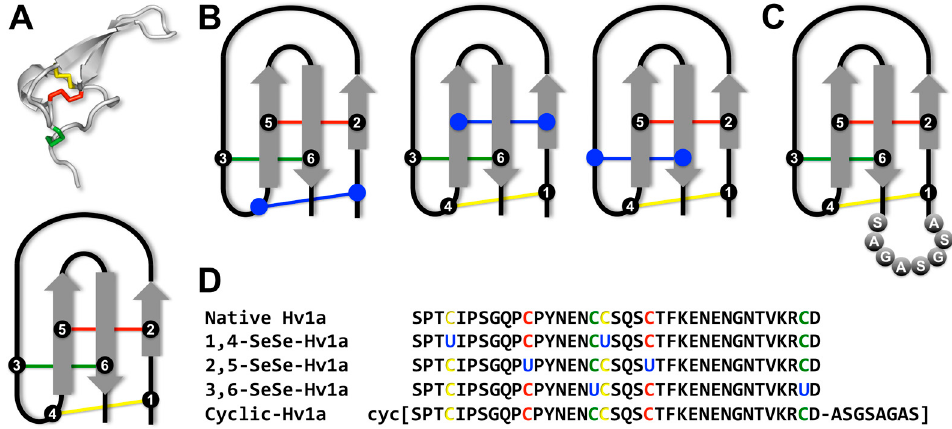
Figure 1. Sequence and structure of Hv1a and analogs with the colors indicating individual disulfide bonds (C1-C4 = yellow; C2-C5 = red and C3-C6 = green) ( A ) Top panel: Three-dimensional structure of native Hv1a (PDB 1AXH; [7]). Bottom panel: Schematic of the inhibitor cystine knot (ICK) motif of Hv1a, which comprises an antiparallel β -sheet (shown in grey) stabilized by a cystine knot. The six cysteine residues that form the cystine knot are labelled 1–6; ( B ) Schematic of the ICK motif for the three diselenide analogs of Hv1a. The blue color indicates replacement of a disulfide bond with a diselenide bond; ( C ) Schematic of the ICK motif for the cyclic Hv1a analog. The eight residues that form the linker bridging the N- and C-termini are labelled; ( D ) Amino acid sequences of native Hv1a and the various analogs used in this study.